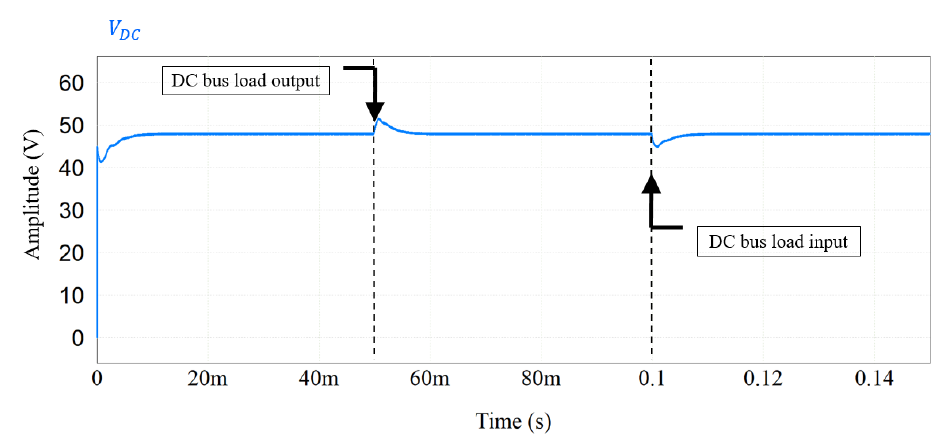
Figure 7. DC Bus Voltage with